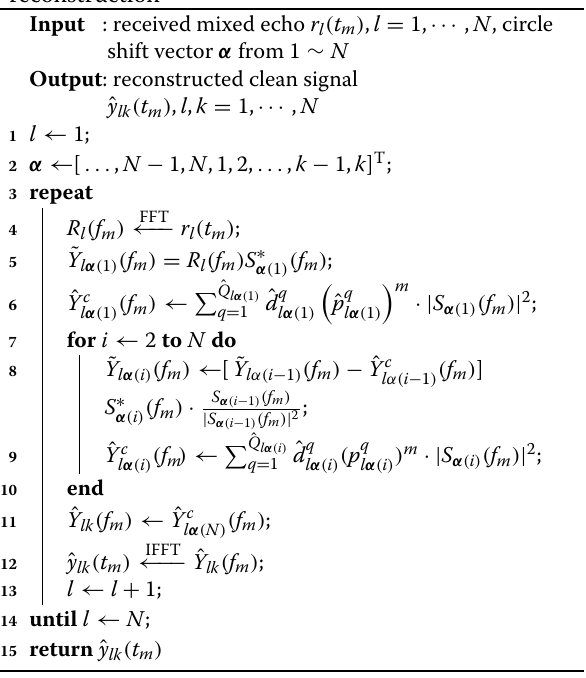
Algorithm 1: R-E-R framework for clean signal reconstruction